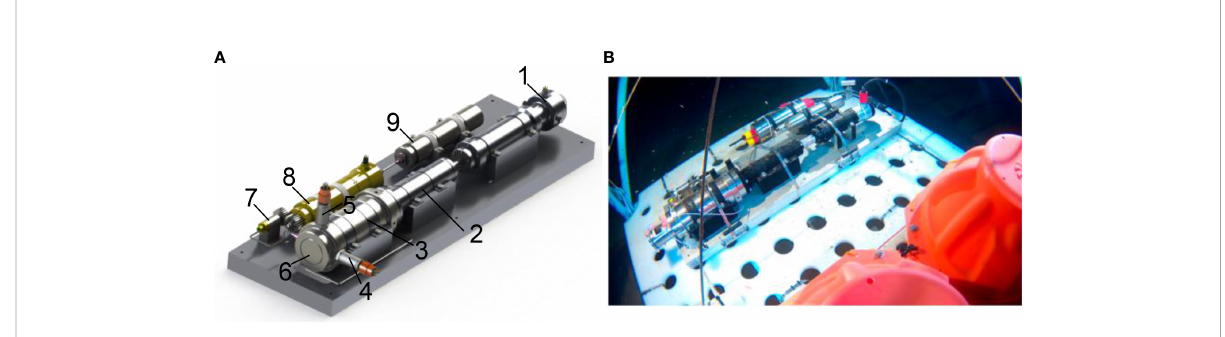
FIGURE 10 Schematic diagram and photo of PMTI (A) : 3D model of PMTI (1: sampling motor; 2: screw mechanism; 3: pressure vessel; 4: temperature probe; 5: pressure probe; 6: sampling piston; 7: pressurizing cylinder; 8: pressurizing motor; 9: piston accumulator); (B) : PMTI working at seabed) (adapted from Wang et al., 2022).